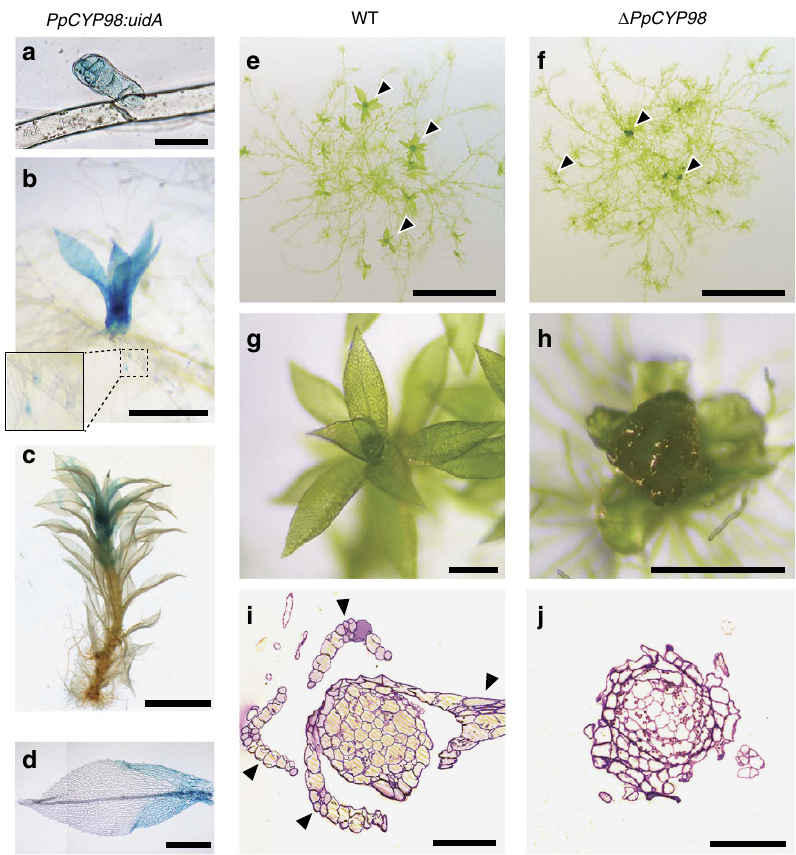
Figure 2 | PpCYP98 is essential for P. patens gametophore development. ( a – d ) GUS staining pattern in PpCYP98:uidA lines indicated a prominent expression in developing gametophores. ( a ) Bud (emerging gametophore). Scale bar, 50 m m. ( b ) Young gametophores. Scale bar, 0.5mm. ( c ) One-month- old gametophore. Scale bar, 2mm. ( d ) Apical leaf from 1-month-old gametophore (joined pictures). No GUS staining is visible in the midrib. Scale bar, 0.5mm. ( e – j ) D PpCYP98 mutants fail to develop normal gametophores. ( e , f ) Six-week-old colonies grown on agar plates. Arrowheads indicate gametophores. Scale bars, 5mm. ( g – h ) Close-up views of gametophores. Scale bars, 0.5mm. ( i , j ) Toluidine blue-stained cross section of gametophores. Arrowheads indicate phyllids in the WT. Scale bars,